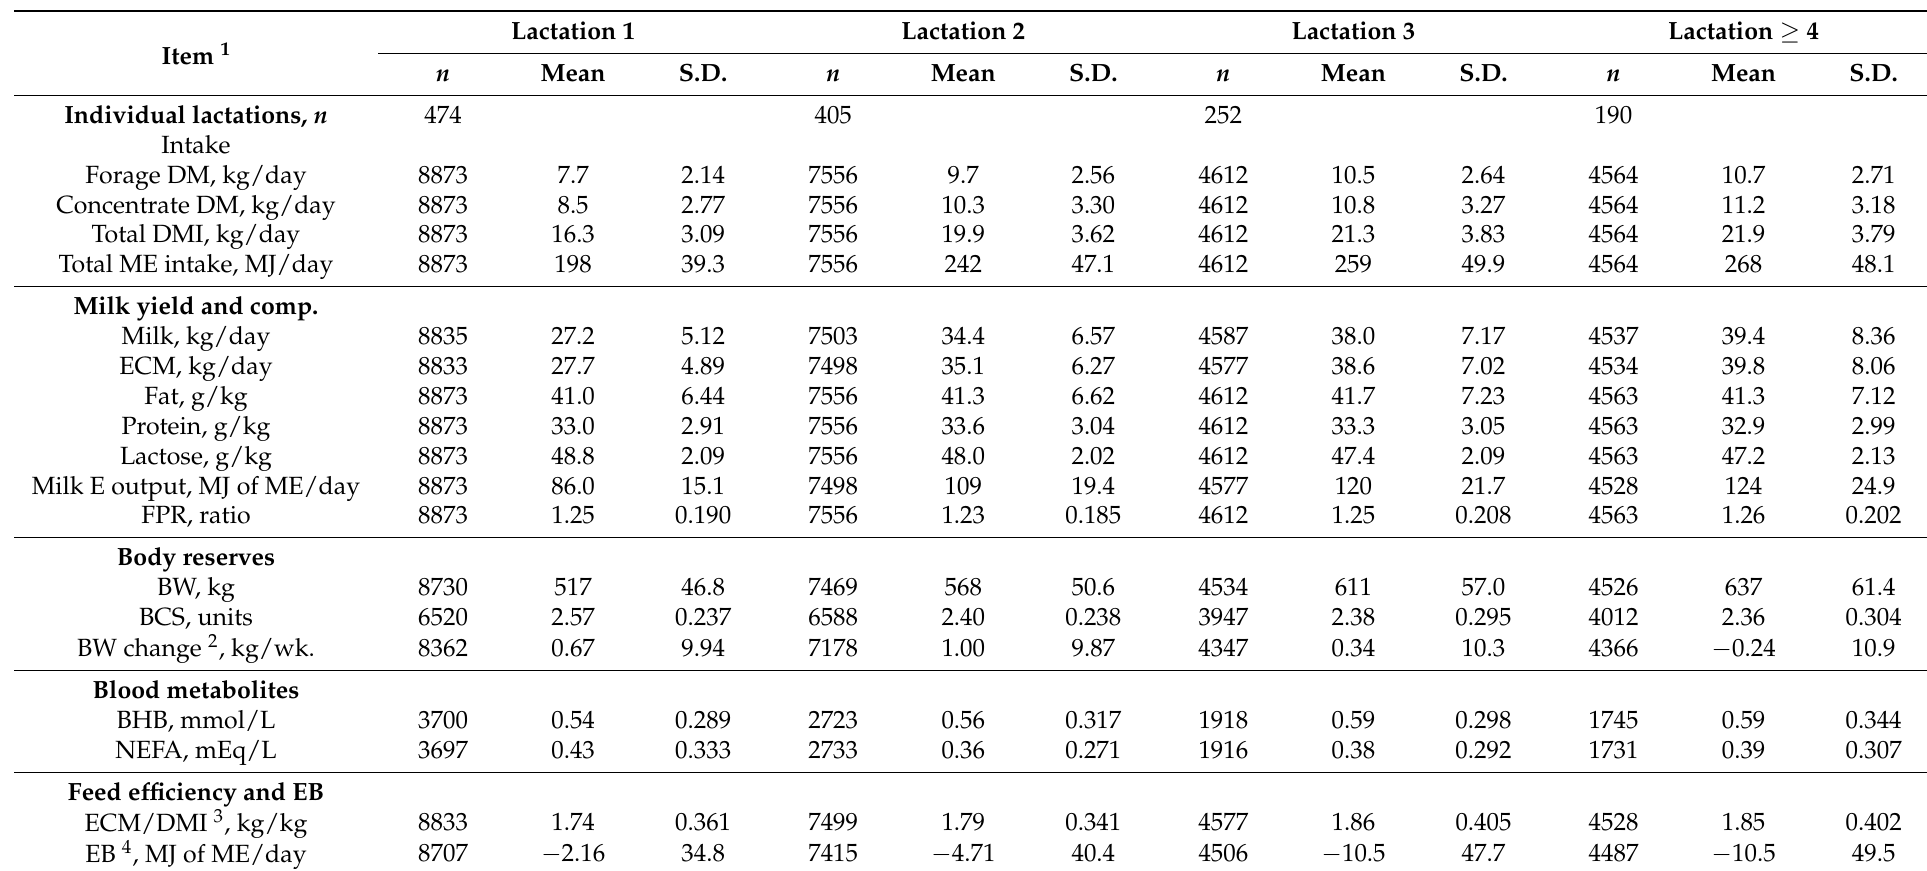
Table 1. Mean and S.D. of data contained within the dataset, arranged by lactation number, obtained from 27 experiments involving 840 individual Holstein-Friesian dairy cows during early lactation (1–20